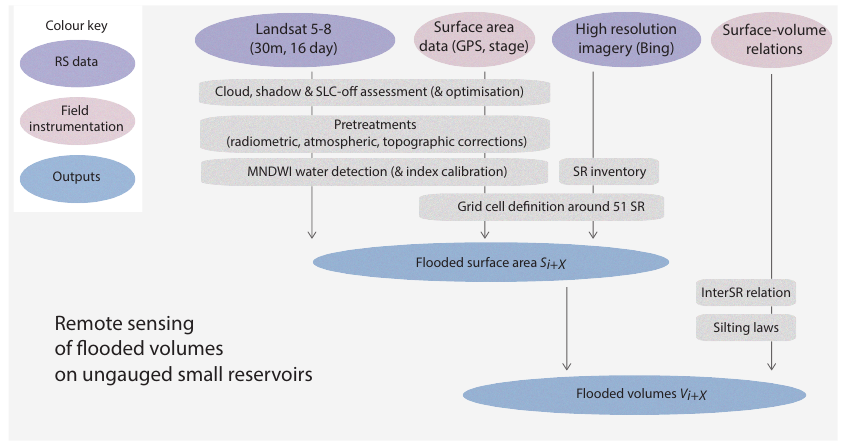
Figure 5. Chain of treatments applied to 546 Landsat images (adapted from